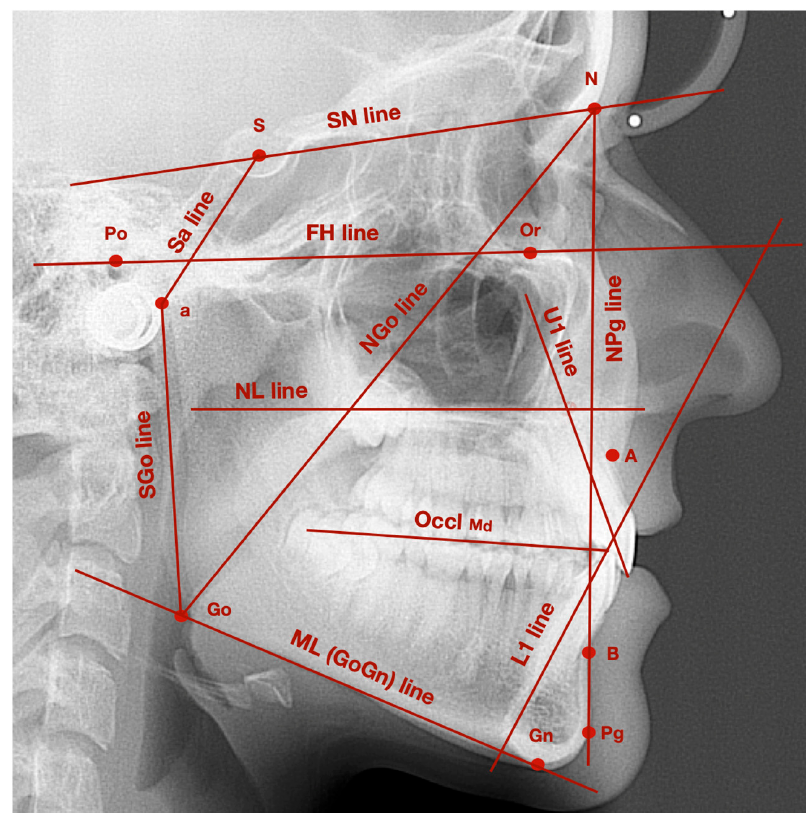
Figure 1. Exemplary lateral cephalogram with marked points and lines described in Table 2.